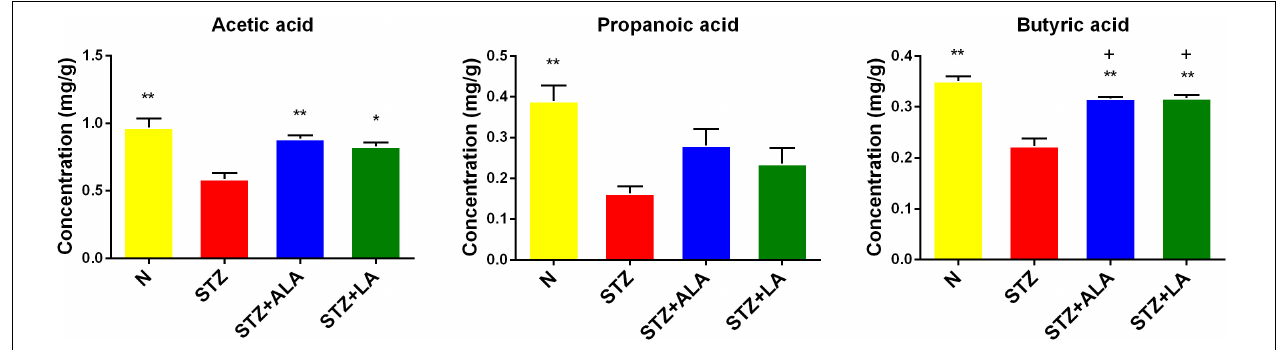
FIGURE 6 | Comparison of fecal SCFA in normal control, the STZ group, the STZ + ALA group, and the STZ + LA group. Data are expressed as mean ± SEM ( n = 5). * p ≤ 0.05, ** p ≤ 0.01. + vs. the normal control group. + p ≤